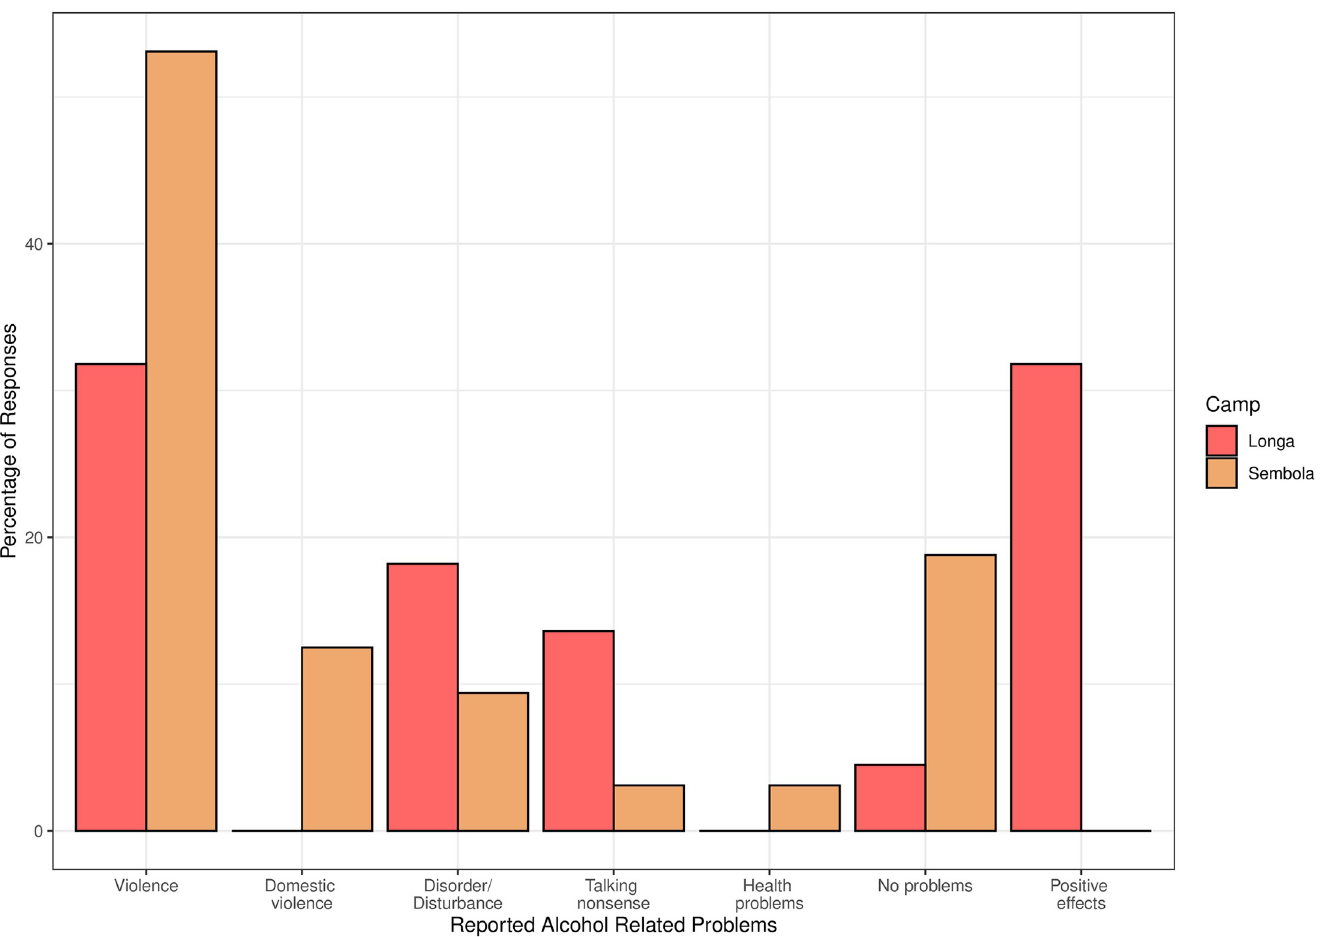
Fig 5. Bar chart of participants’ responses to whether alcohol causes problems, separated by